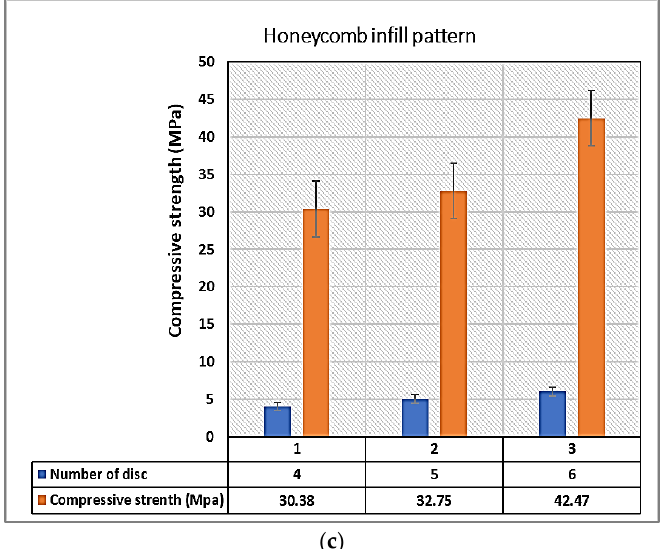
Figure 5. Comparison of mechanical strength with the number of discs with varying infill patterns for ( a ) linear, ( b ) triangular, and ( c ) honeycomb patterns.